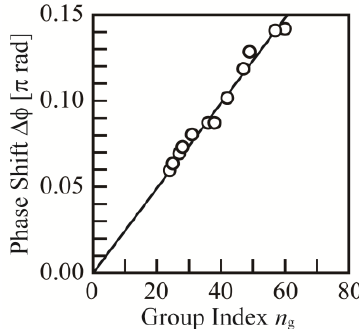
Figure 10. The Δφ estimated from ER as a function of n g .